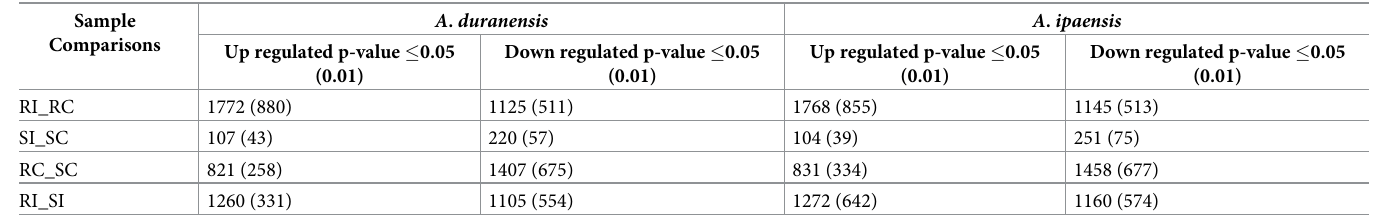
The values in parenthesis are transcripts having a p-value �